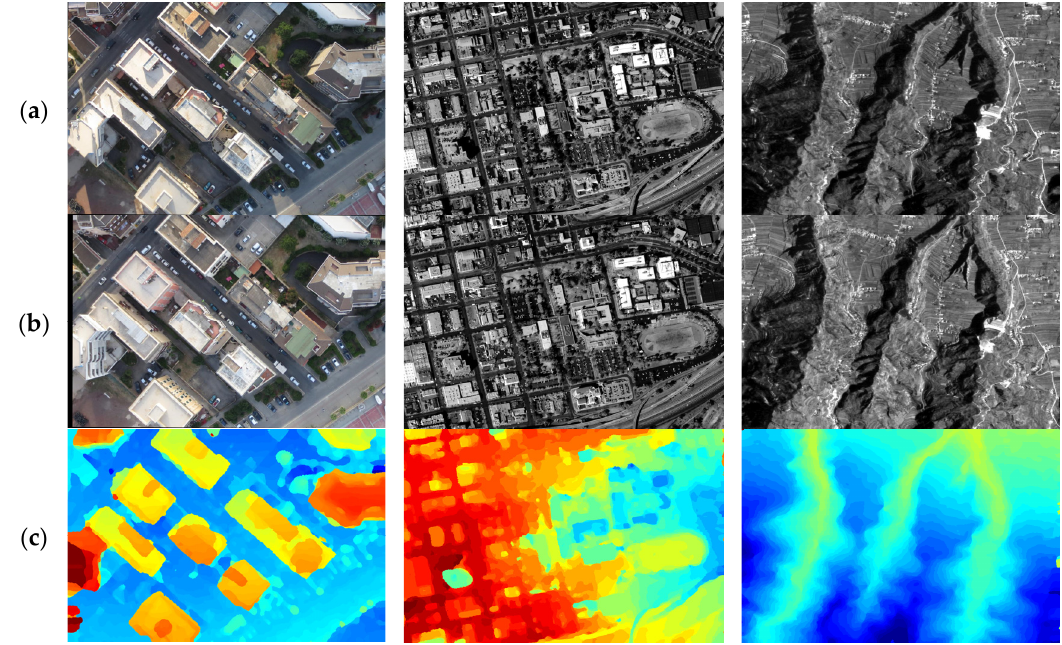
Figure 9. Disparity maps of remote sensing images. ( a ) Left image of the scene ( b ) Right image of the scene ( c ) Disparity maps obtained by the proposed algorithm.